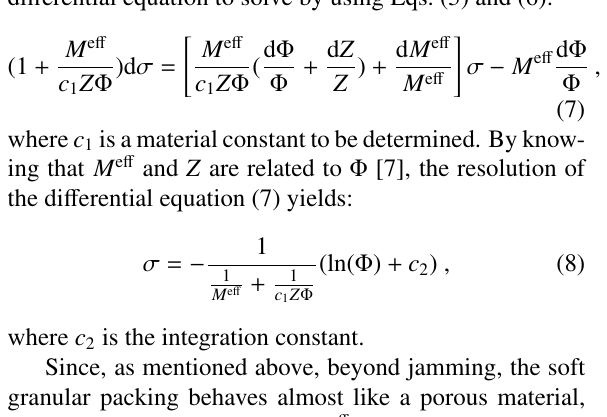
Figure 3. Evolution of the excess applied stress  malized by the grain bulk modulus K as a function of packing fraction  for neo-Hookean grains.  c corresponds to the jam- ming point,  c 0 . 8. The lines show the predicted behaviors ' beyond the jamming state by the compaction models introduced in Eq.